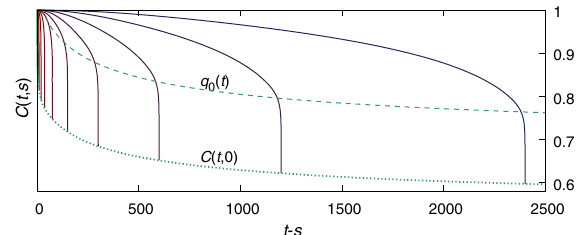
FIG. 4. Correlation function C ð t; s Þ for initial temperature T ¼ 0 . 813 ¼ 1 . 01 T as a function of t − s for fixed values of MCT t ¼ 2400 × 2 − n , with n ¼ 0 ; … ; 9 (from right to left). The correlation shows clear aging features, becoming slower for larger times. After the slow decay, at a well-defined value q t Þ (dashed line), the correlation displays a sudden drop to 0 ð C ð t; 0 Þ (dotted